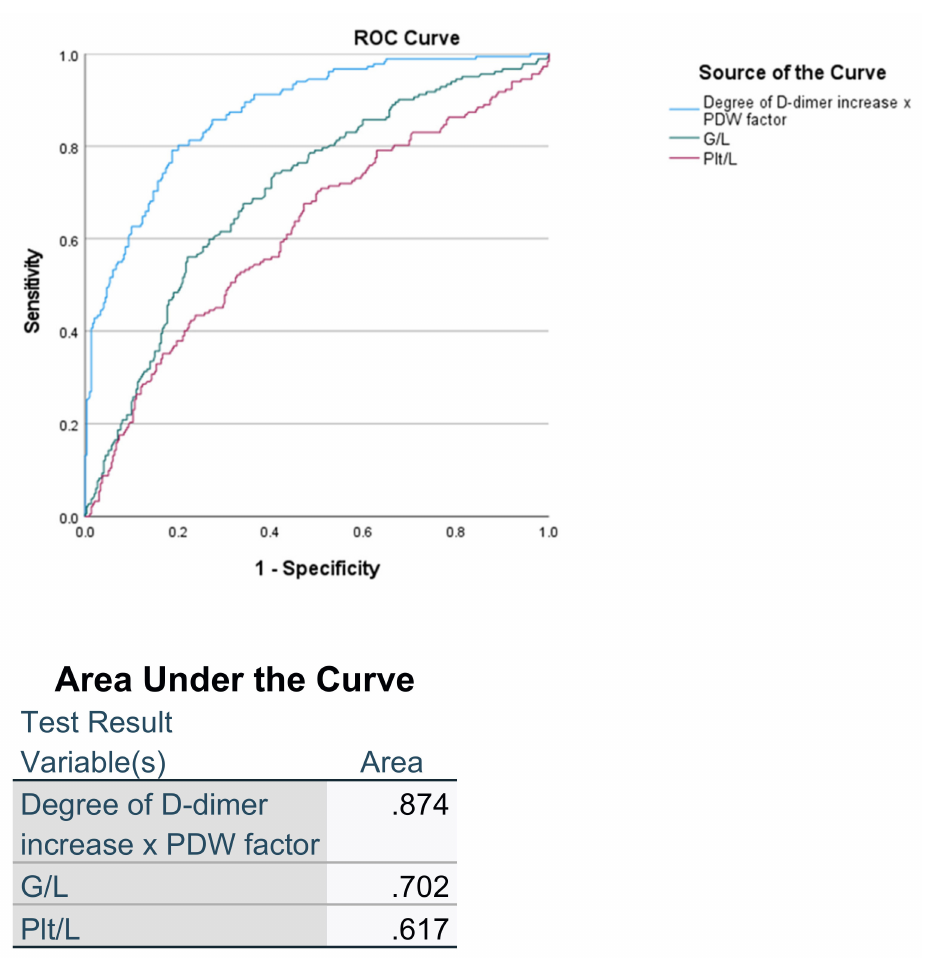
Figure 4. ROC curve comparing sensitivity and specificity of predicting the ARDS between D-PDWf, G/L and Plt/L.